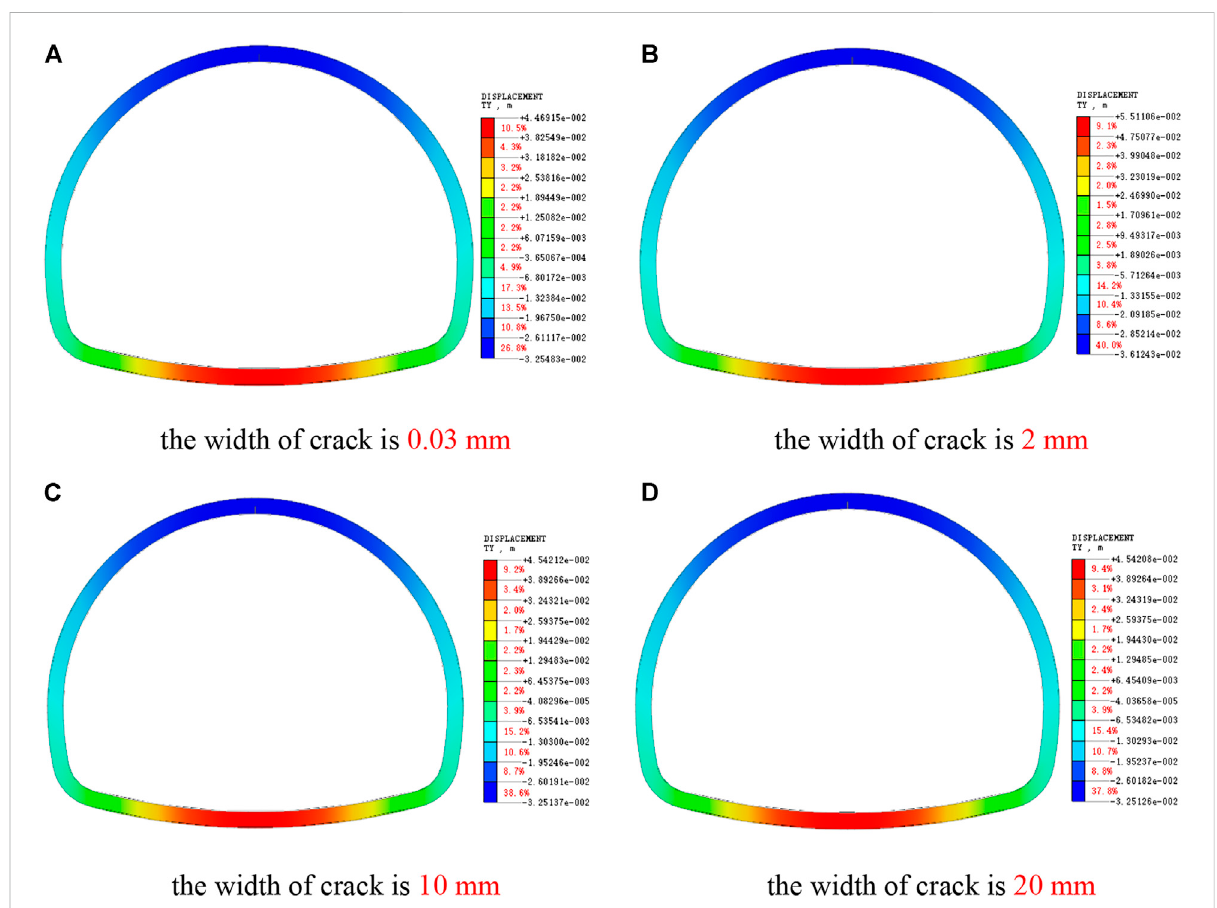
FIGURE 7 CloudpictureofY-direction displacement ofvaultcrack lining. (A) Thewidth ofcrackis0.03 mm. (B) The widthofcrackis2 mm. (C) Thewidth of crack is 10 mm. (D) The width of crack is 20